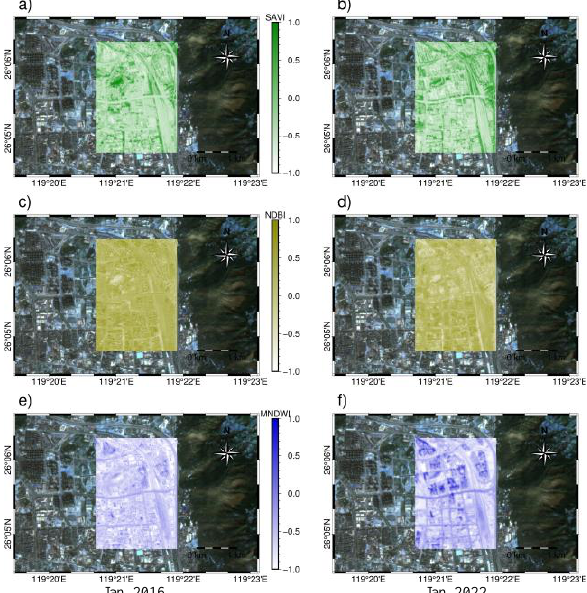
Jan. 2022 Figure 6 . The SAVI, NDBI and MNDWI values of area A at January 2016 and January